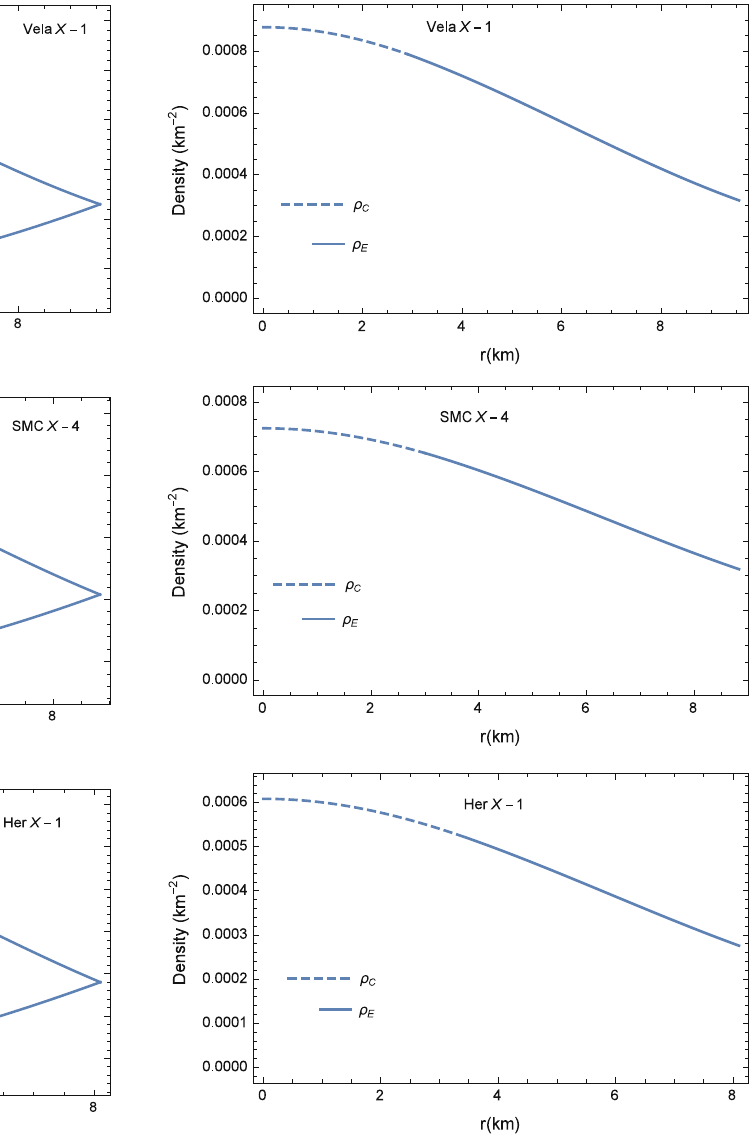
Fig. 1 Variation of metric potentials with radial coordinate r for (i) the neutron star in Vela X-1(upper) (ii) SMC X-4 (middle) (iii) Her X-1 (lower)